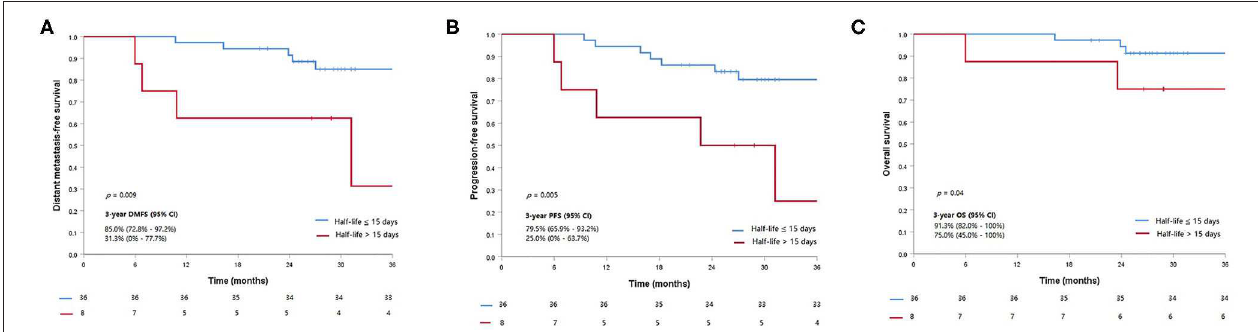
FIGURE 2 | Kaplan–Meier curves of the prespecified survival endpoints including (A) distant metastasis-free survival, (B) progression-free survival, and (C) overall survival, stratified by the half-life clearance of plasma Epstein–Barr virus (EBV) DNA ( > 15 vs. ≤ 15 days).